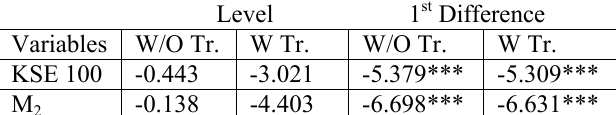
Table 2: Unit roots